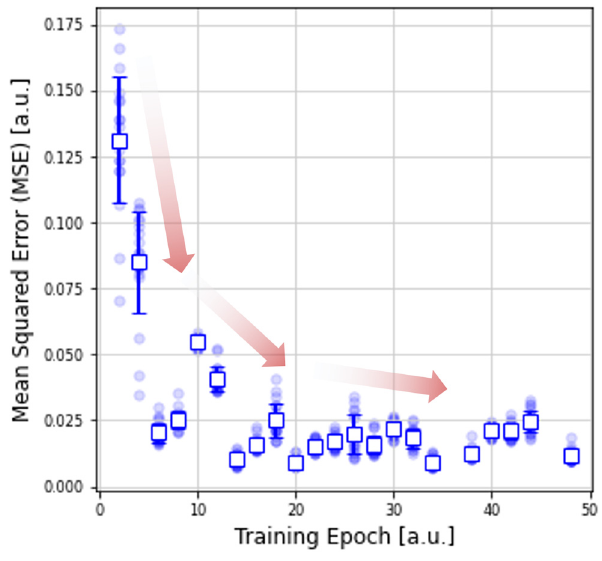
Figure 7. Evaluation metrics of the proposed parameter extraction technique using ANNs. MSE as a function of the training epoch. The MSE is computed between the measured I ‐ V loop and the one obtained by simulation using the ANN fitted parameters.